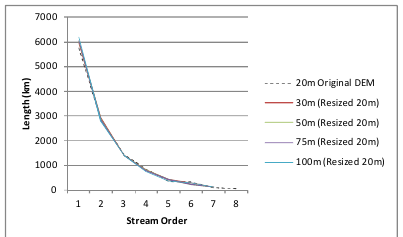
Figure 10. Overall waterways derived from 20m DEM resized to 30m, 50m and 75m and 100m DEMs